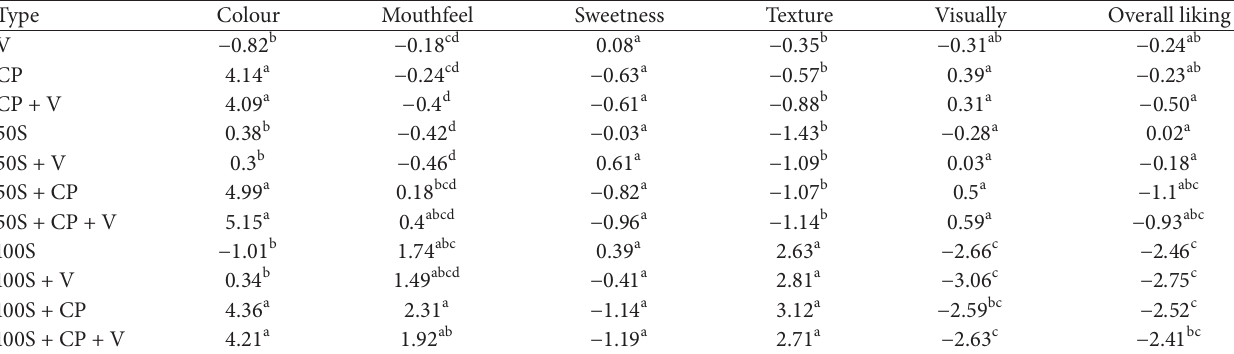
Table 5: Sensory evaluation of half-sugar/sugar-free muffins in comparison with the control muffin which was taken as relative value and processed factor values for each experimental